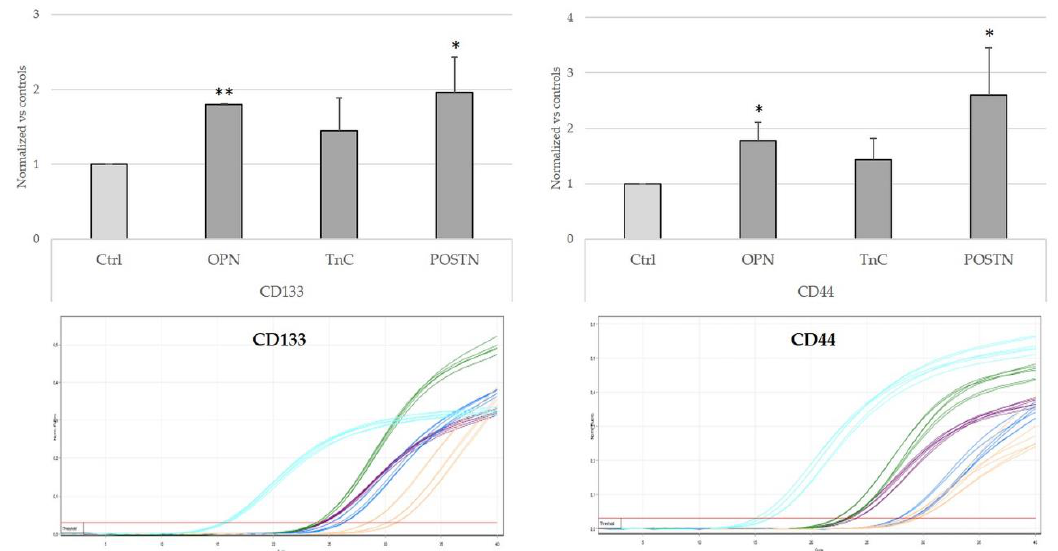
Figure 7. OPN and POSTN but not TnC stimulated expression of the CSC markers CD133 and CD44